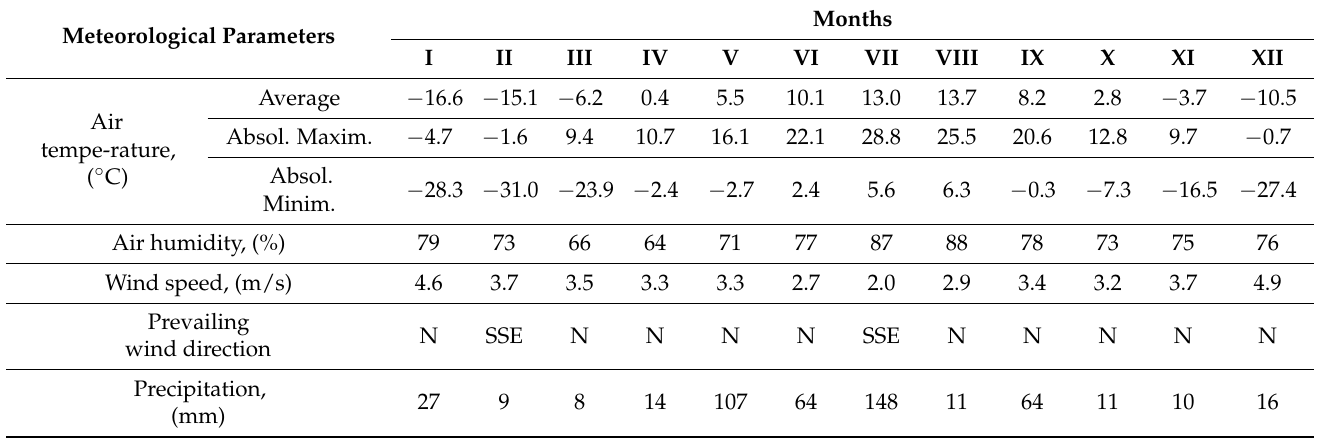
Table 1. Meteorological conditions at the Listvynaka station in